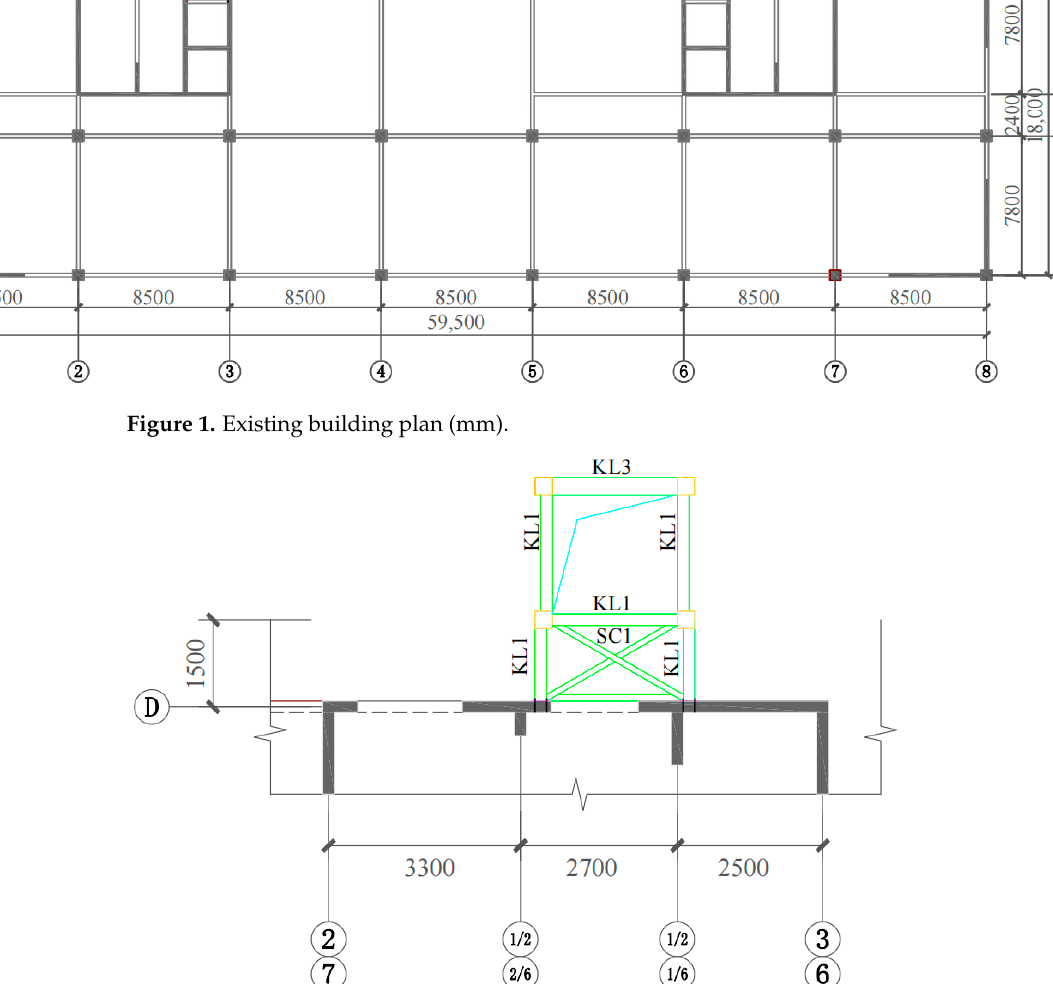
Figure 1. Existing building plan (mm).